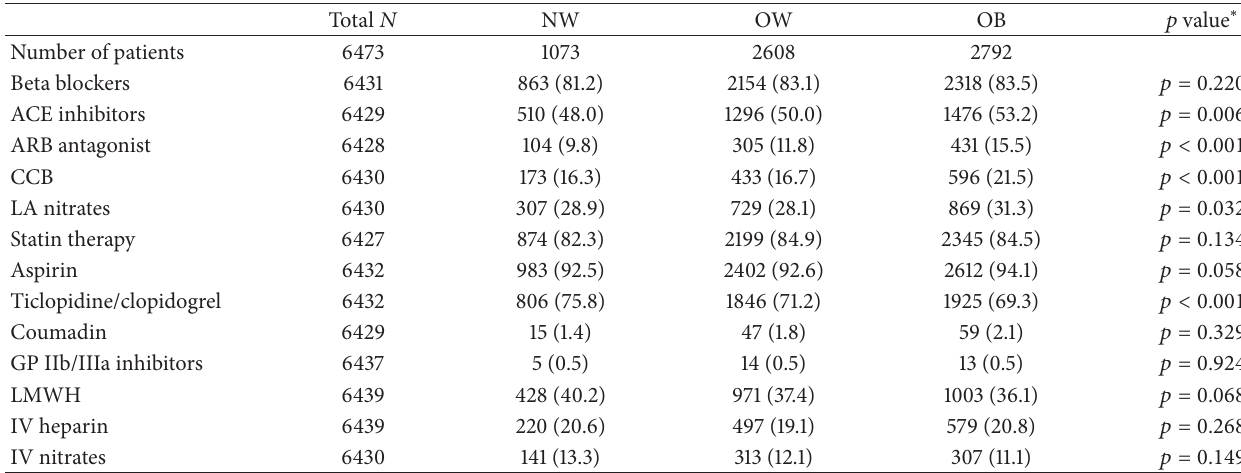
Table 2: Medications at time of referral for PCI by BMI